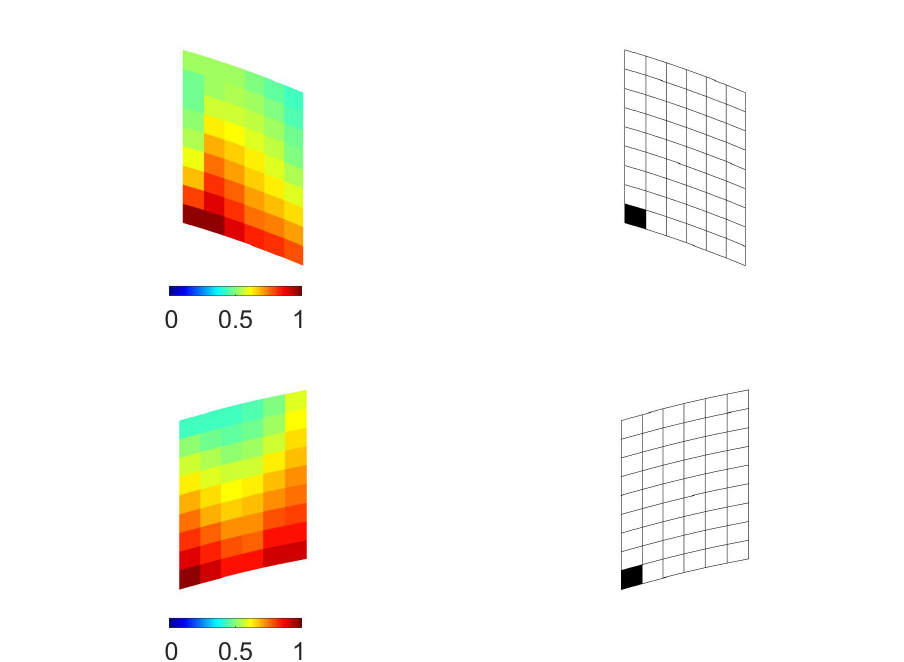
Figure 12. Stiffened fuselage section problem, Case (2), mesoscale analysis: ( left ) contour plots of the local objective function ψ m , and ( right ) relevant optimal sensor placement with N m = 1; results reported for ( top ) i = 69 and ( bottom ) i =